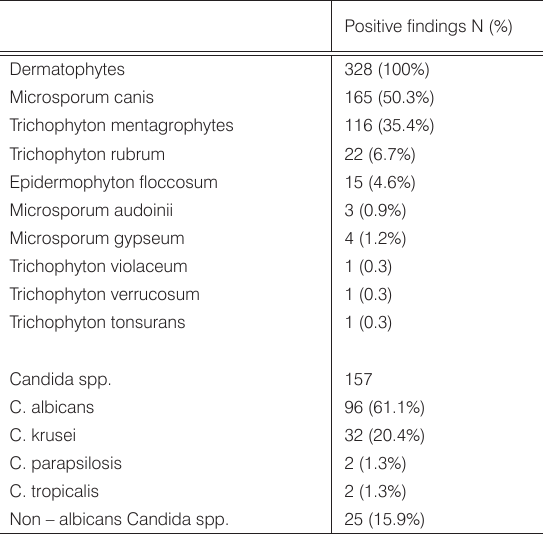
Table 1 Dermatophytes and Candida spp. isolates from material of patients from Niš